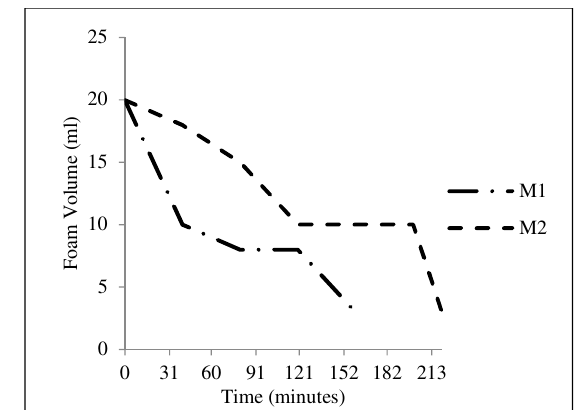
FIG. 2. GENERATED FOAM VOLUME AND ITS STABILITY BY SURFACTANT SOLUTION OF M1AND M2 The foam was generated by shaking of 5 minutes and foam volume was recorded after drain out of liquid from the test tube. About 20ml foam was generated by M1 surfactant solution, whereas, M2 surfactant solution generated 22ml foam. Once the foam was generated in the test tube, the generated foam height was decreased due to the force of gravity (liquid drain through the lamellae). The foam volume of M1 was decreased continuously with time. Surfactant